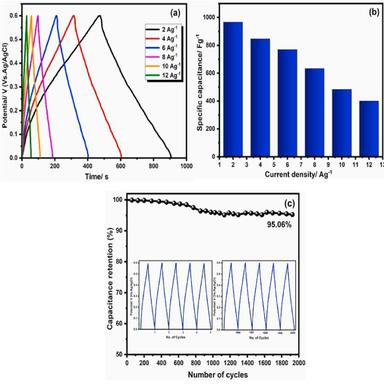
(a) GCD curves of GVO/MX at various current densities changing from 2 Ag-1 to 12 Ag-1, (b) Csp as a function of current density for GVO/MX, (c) Cyclic stability of GVO/MX up to 1000 GCD cycles.